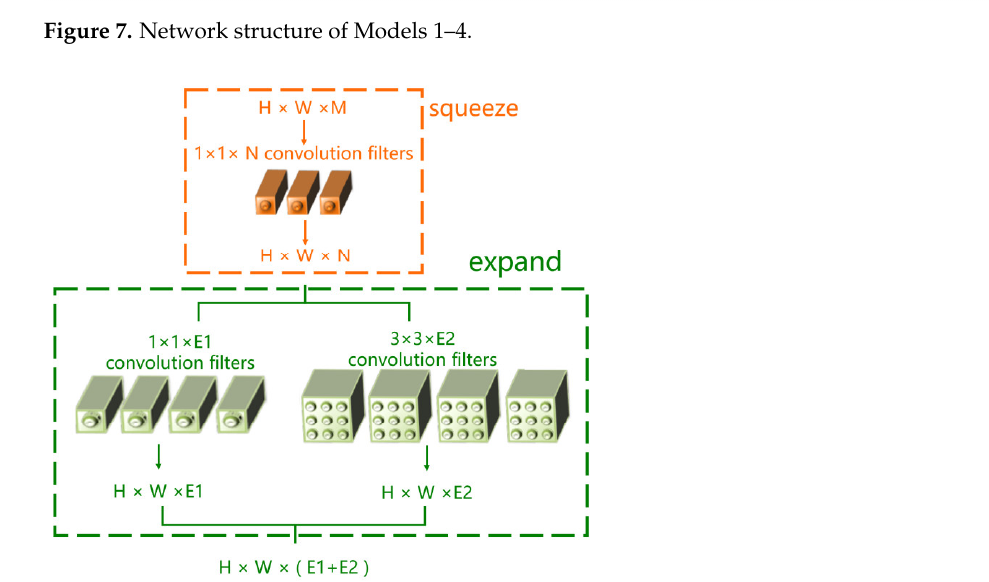
Figure 7. Network structure of Models 1–4.